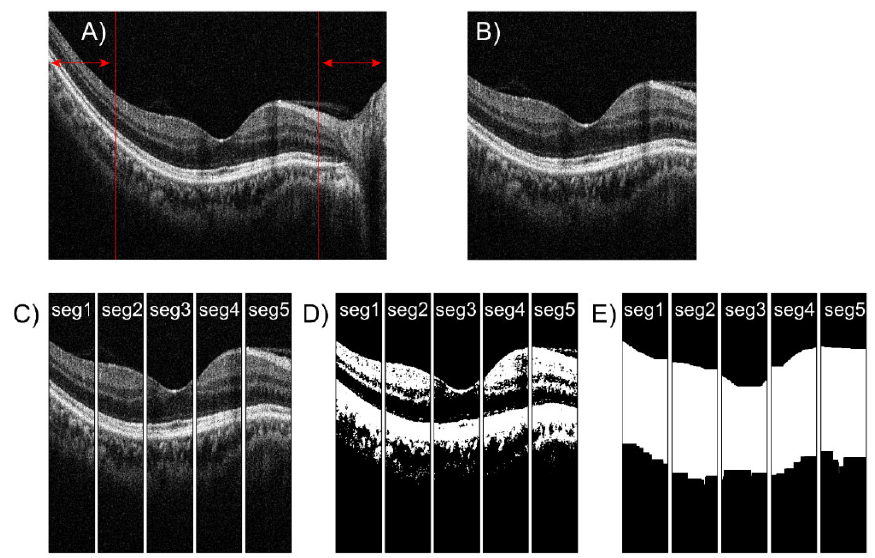
Figure 6. All original OCT images ( A ) had 20% of pixels removed from the right and left edges (red line and red arrows) to avoid ( B ) depression of the optic disk. ( C ) The OCT images were divided into five sections, each with a resolution of 123 × 1176 pixels. The peripheral temporal retina, temporal perimacular area, central macular area, nasal perimacular area, and peripheral nasal retina were defined as segments 1, 2, 3, 4, and 5, respectively. ( D ) Each section was binarized using the discriminant analysis method. ( E ) Morphological closing was applied to these segment images to pad the dark area related to the inner retinal layer and choroidal vessels. The sum of the retinal and choroidal areas was then calculated. Abbreviations: OCT, optical coherence tomography; ML, machine learning; seg, segment.